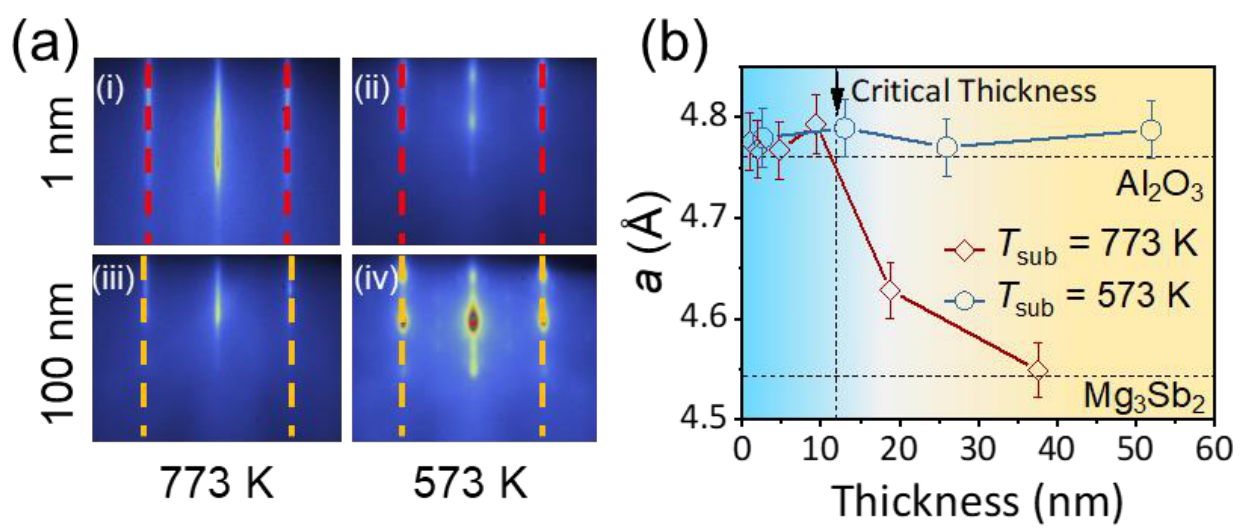
Figure 3. The evolution of in-plane lattice parameter with the deposition time for Mg 3 Sb 2 films. ( a ) The evolution of RHEED patterns with thickness along the [10 1 0] azimuthal direction of films. i. grown at T sub = 773 K with thickness of 1 nm; ii. grown at T sub = 573 K with thickness of 1 nm; iii. grown at T sub = 773 K with thickness of 100 nm and iv. grown at T sub = 573 K with thickness of 100 nm. The unchanged interval of RHEED streaks indicates the full strain state in the film grown at T sub = 573 K. ( b ) The in-plane lattice parameter a as a function of film thickness for films grown at T sub = 773 K and 573 K, quantified by the in situ RHEED measurements.